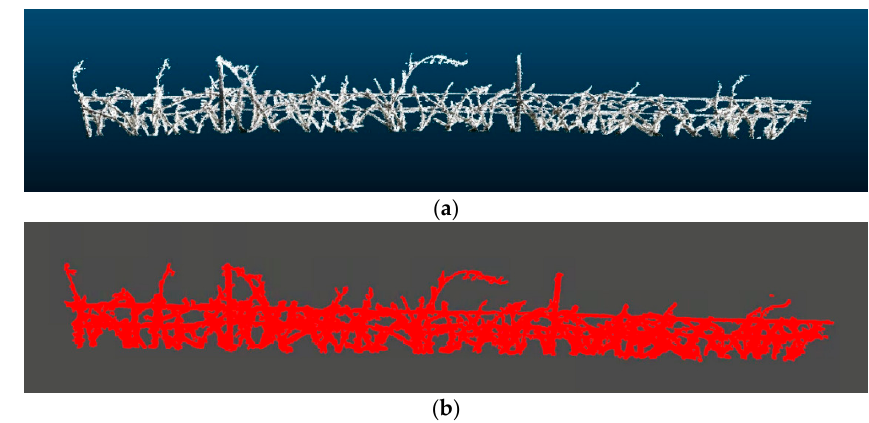
Figure 4. ( a ) Example of 3D reconstruction of a scanned point cloud of a vineyard row after outlier filtering. ( b ) Alpha shape of the point cloud showed in ( a ) with alpha = 0.1 that represents the outline that surrounds a set of 3D points.